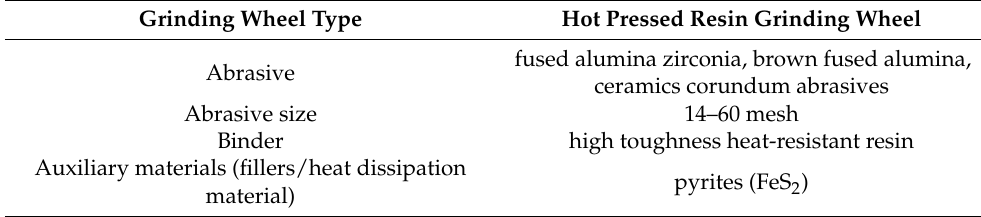
Table 3. Composition of passive grinding wheels.